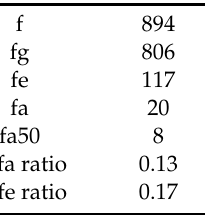
Table 1. Demographic parameters of the border collie breed in Hungary.